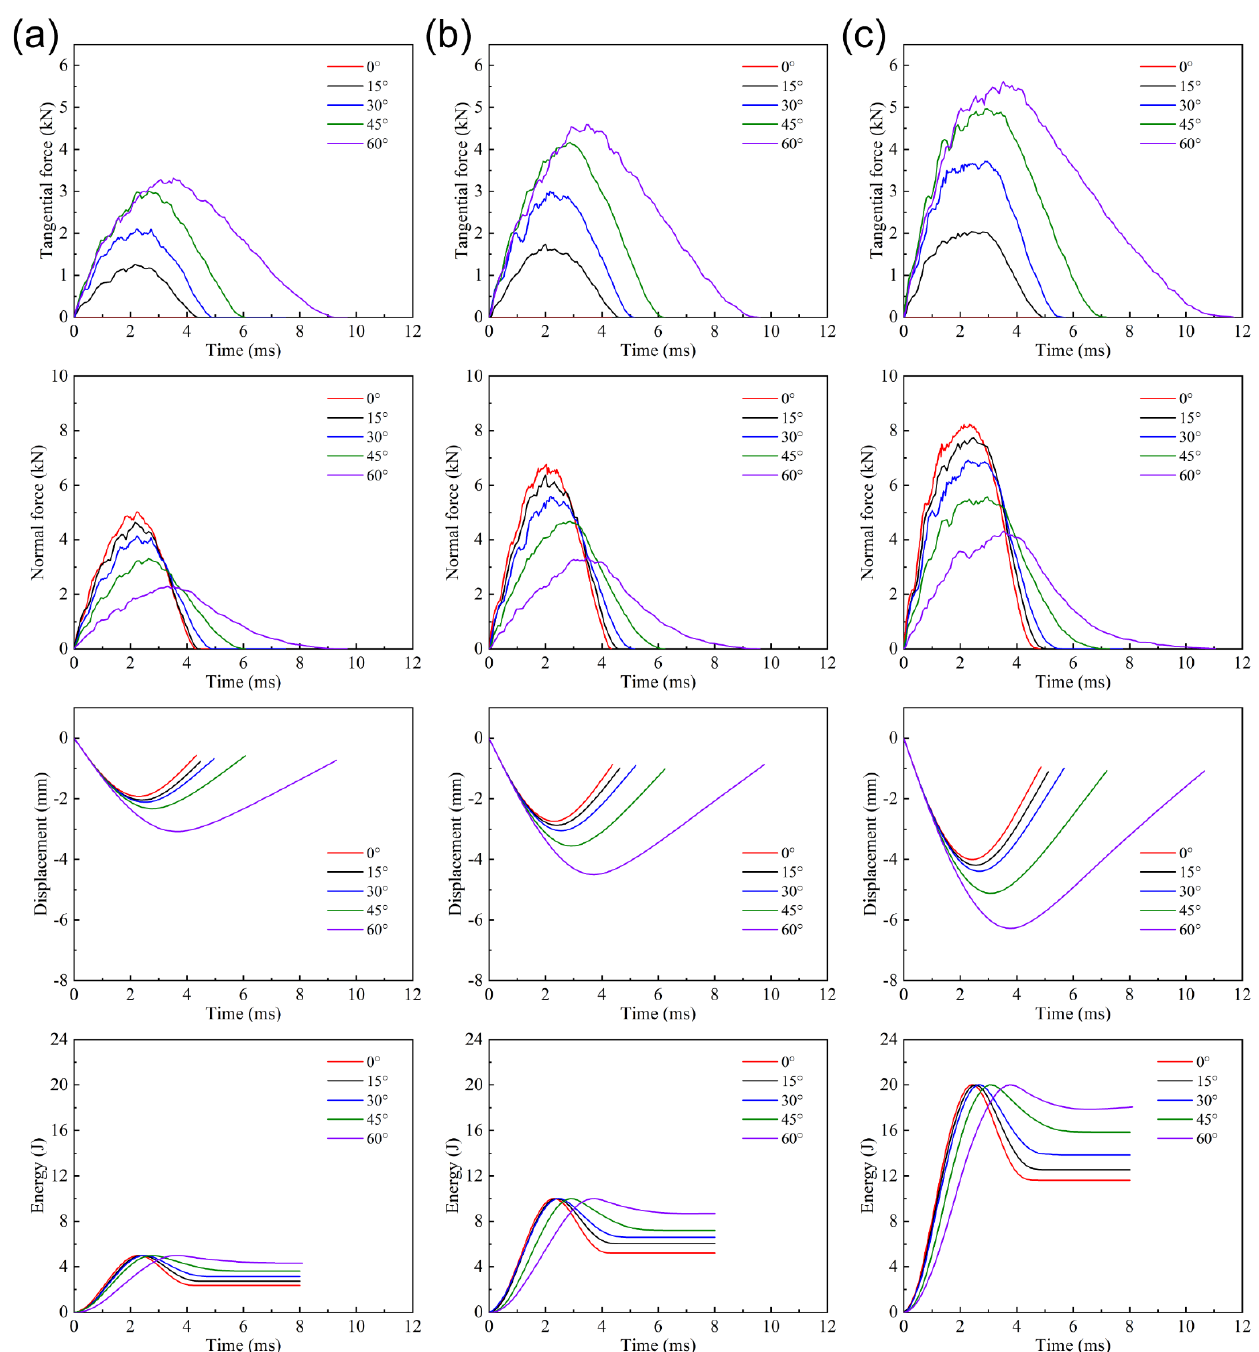
Figure 2. Impact responses with different impact angles under ( a ) 5 J, ( b ) 10 J, and ( c ) 20 J impact energies.